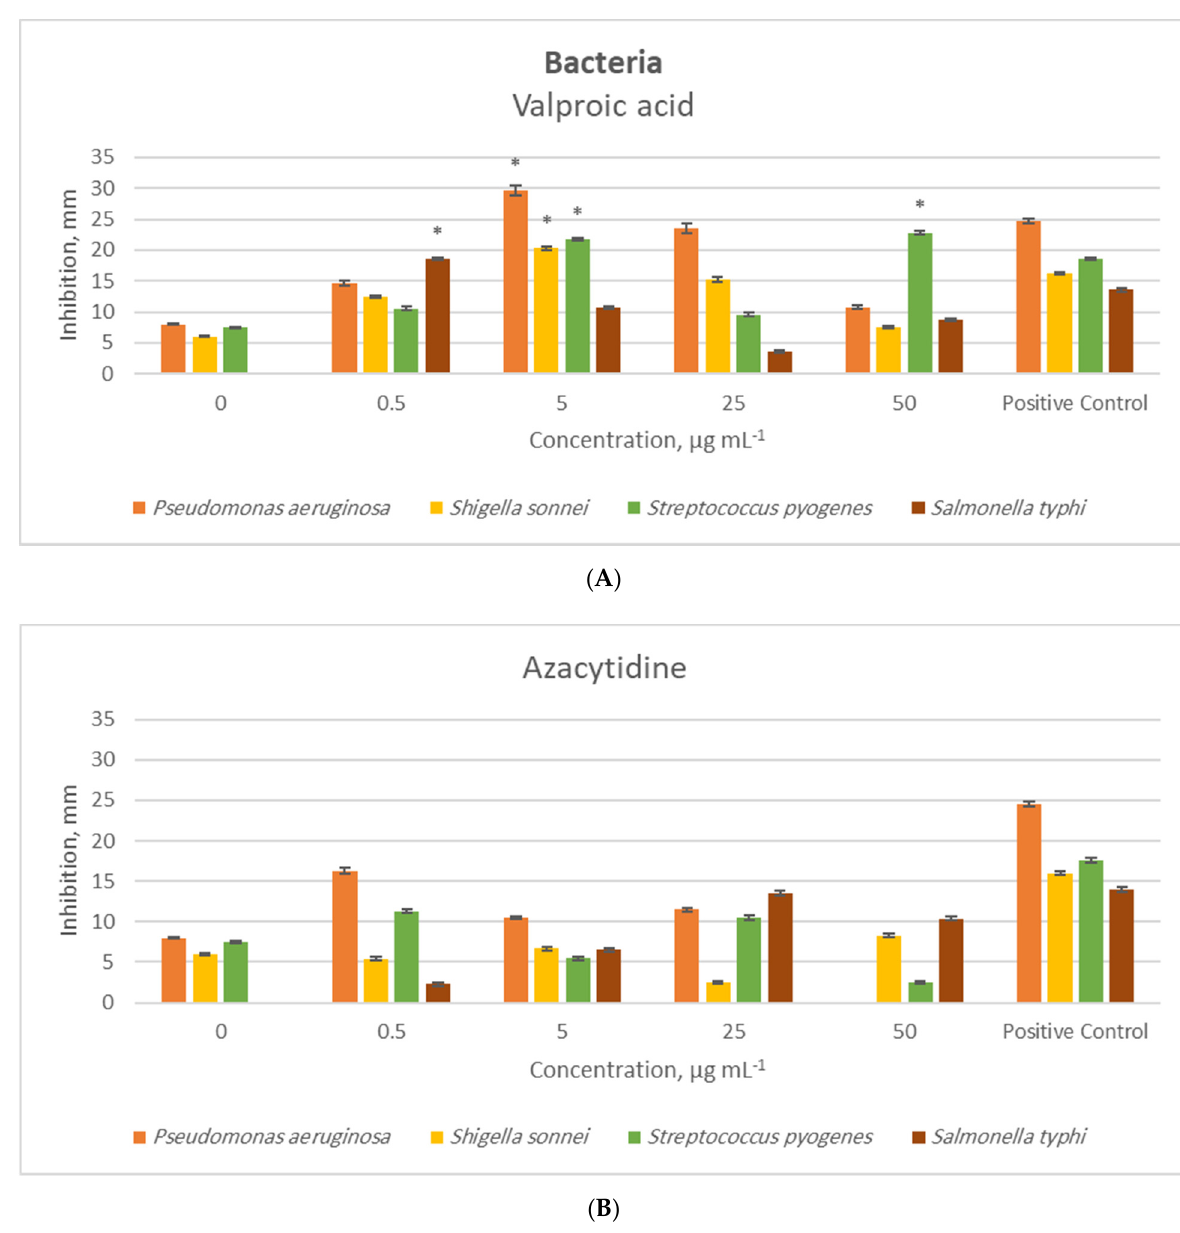
Figure 1. Antibacterial activity (zone of inhibition, mean, and SD error bars, n = 3) of the crude extract of the endophytic fungus P. heveicola cultured with different concentrations of the epigenetic modifiers valproic acid ( A ) and 5-azacytidine ( B ), where 0 μ g/mL refers to the control treatment. The positive control contains ampicillin + tetracycline. * indicates significant difference ( t -test, p < 0.05) from the positive control.